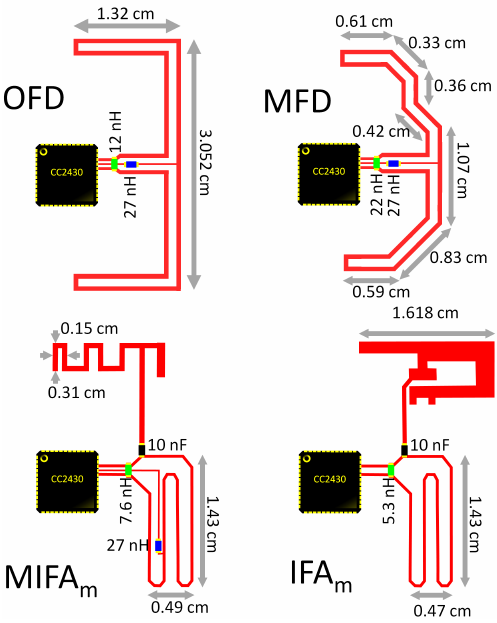
Figure 2. Layout of the selected antennas. Table 1. Antenna selection table based on compliance with design